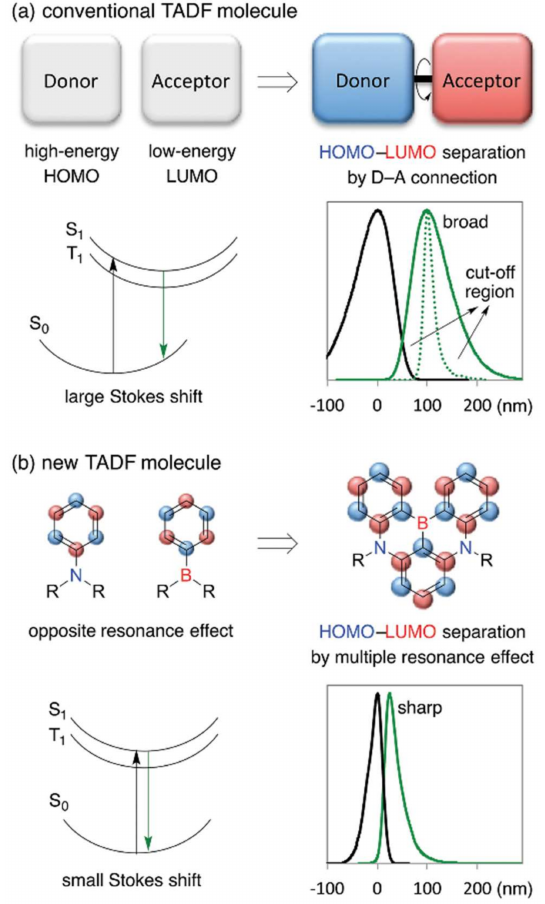
Figure 7. Comparative representation of energy diagram for a traditional TADF emitter ( a ) and the design developed to generate a multiple resonance effect ( b ). The curve corresponding to the emission spectrum of a benchmark blue OLED is provided as the green dotted line. Figure reproduced with permission from Hatakeyama et al. [95] (reproduced with permission from [95] Copyright Wiley-VCH,